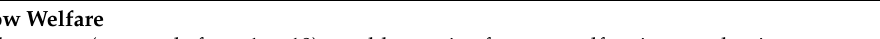
Table 1. Overview of questions asked to the experts regarding welfare scores for 15 dimensions (the answering options are explained after the